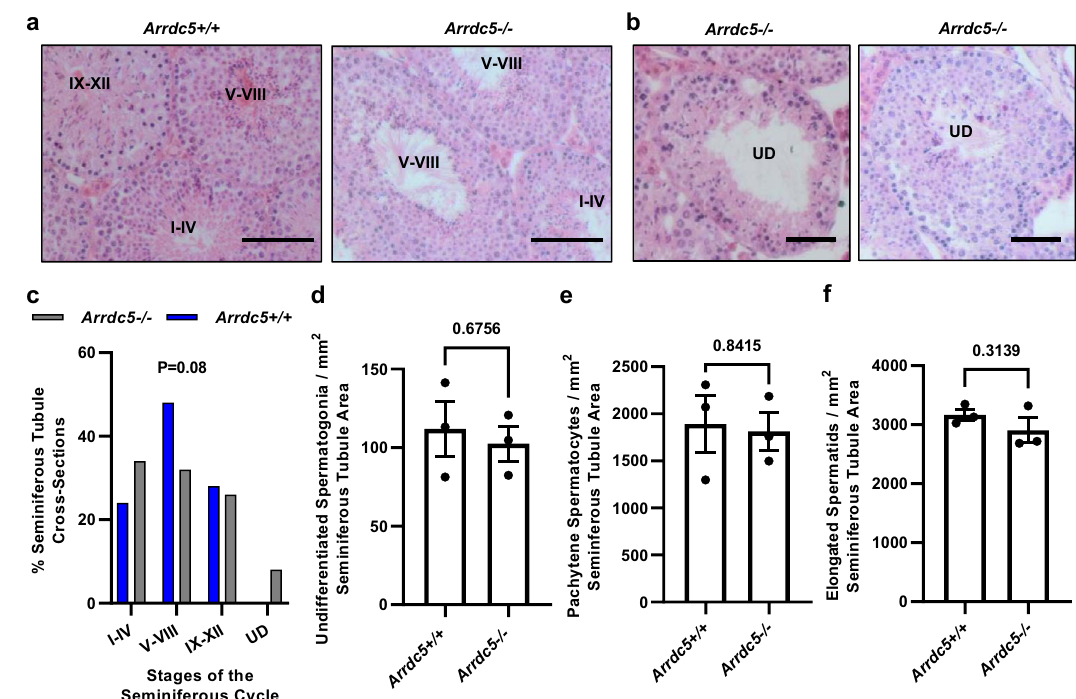
Fig. 5 | Assessment of spermatocytogenesis in Arrdc5 − / − mice. a Seminiferous tubule cross-sections from testes of adult Arrdc5 + /+ and Arrdc5 − / − littermates. Tubulesatdifferentgroupingsforthestageoftheseminiferouscycleareindicated. Barsare50 μ m. b Seminiferoustubulecross-sectionsfromtestesofadult Arrdc5 − / − mice for which a stage of the seminiferous cycle was not de fi nable (indicated at unde fi nedorUD).Barsare50 μ m. c Quantitativecomparisonofdistributionforthe 12 stages of the seminiferous cycle in cross-sections of testes from adult Arrdc5 + /+ and Arrdc5 − / − littermates, grouped as I – IV, V – VIII, and IX – XII. Data bars are mean for at least 50 cross-sections from n =3 different animals of each genotype. Cross-